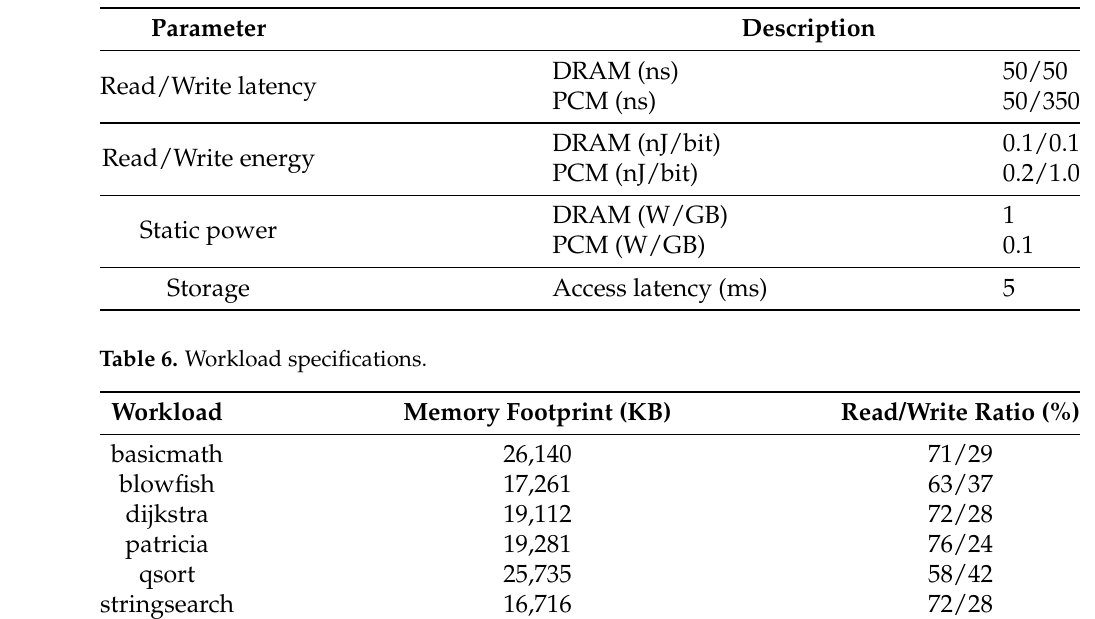
Table 5. Experimental parameters.